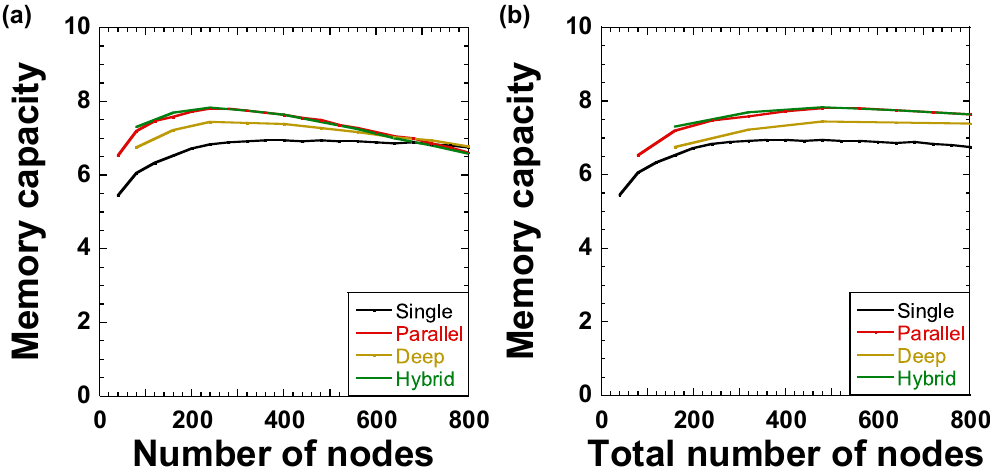
for all total is N for the single configuration and 2 N total is matched to N for all four configurations. total